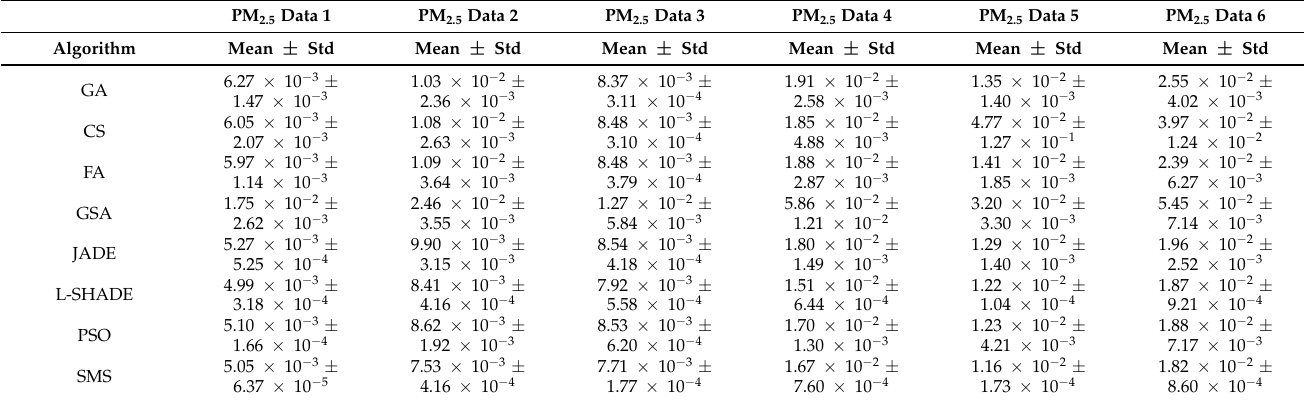
Table 5. Experimental results of the dendritic neural network model (DNN) for the PM 2.5 concentration data and different training optimization